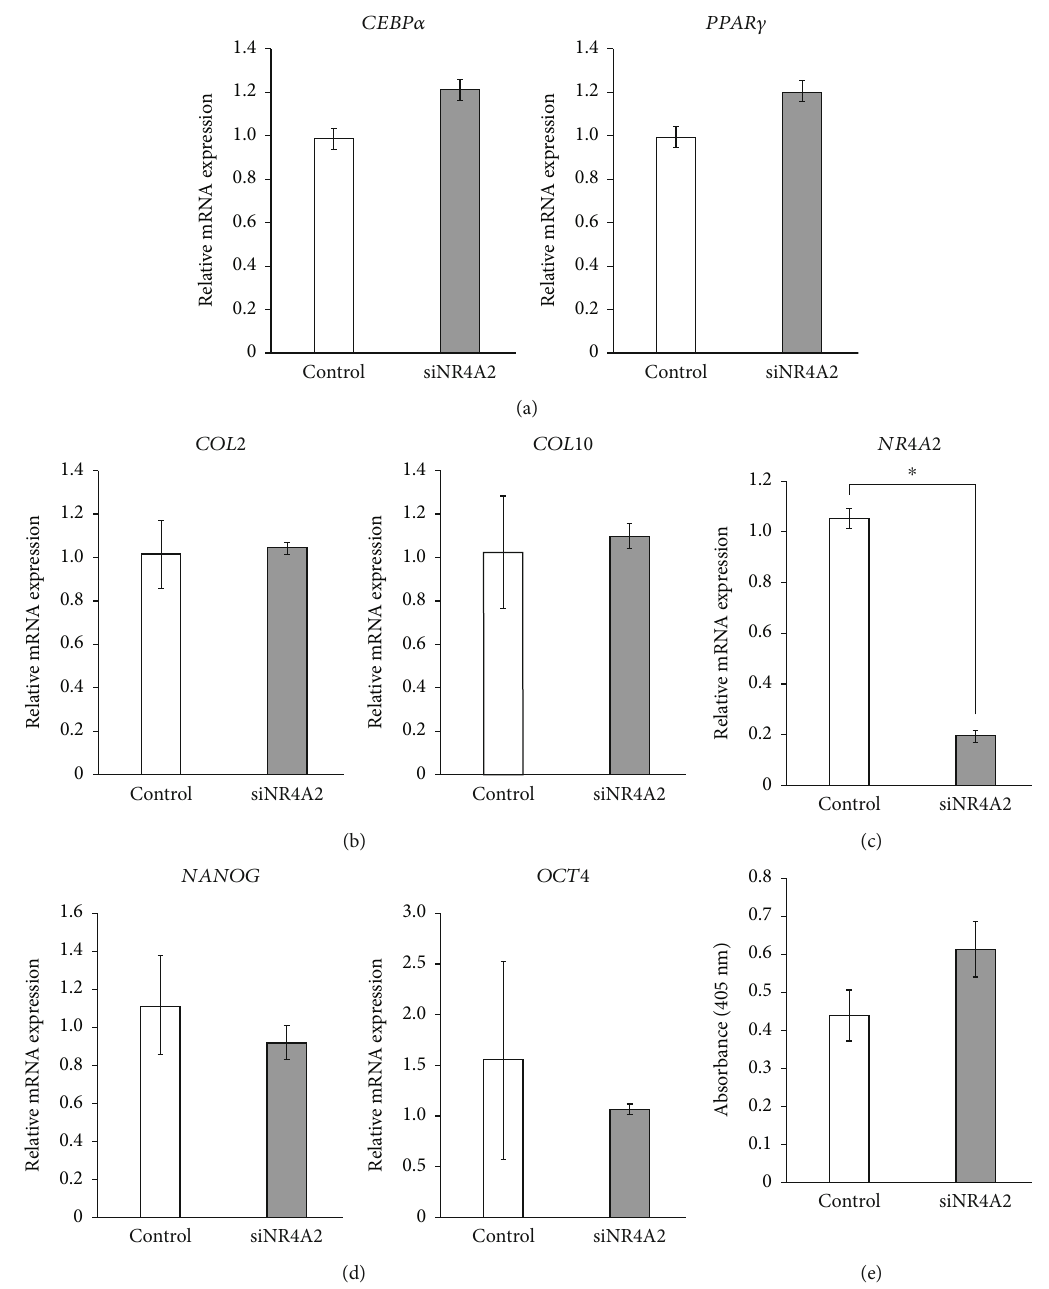
Figure 6: E ff ects of NR4A2 on chondrogenesis and adipogenesis in hPDLMSC spheroids and osteogenesis in monolayer-cultured hPDLMSCs. (a) E ff ects of siNR4A2 on CEBP α and PPAR γ mRNA expression in monolayer-cultured hPDLMSCs with adipogenic di ff erentiation medium. On day 7, the expression of CEBP α and PPAR γ mRNA was examined by real-time RT-PCR. (b) E ff ects of siNR4A2 on COL2 and COL10 mRNA expression in monolayer- cultured hPDLMSCs with chondrogenic di ff erentiation medium. On day 7, the expression of COL2 and COiL10 mRNA was examined by real time RT-PCR. (c) Con fi rmation of silencing of NR4A2 by siRNA in monolayer-cultured hPDLMSC. NR4A2 siRNA decreased mRNA expression of NR4A2. (d) E ff ects of siNR4A2 on Nanog and Oct4 mRNA expression in monolayer-cultured hPDLMSCs. The expression of NR4A1 and NR4A3 mRNA was examined by real-time RT-PCR. (e) E ff ects of siNR4A2 on ALP activity in monolayer-cultured hPDLMSCs cultured with OIM. On day 7, ALP activity was measured. All experiments were performed with samples from four